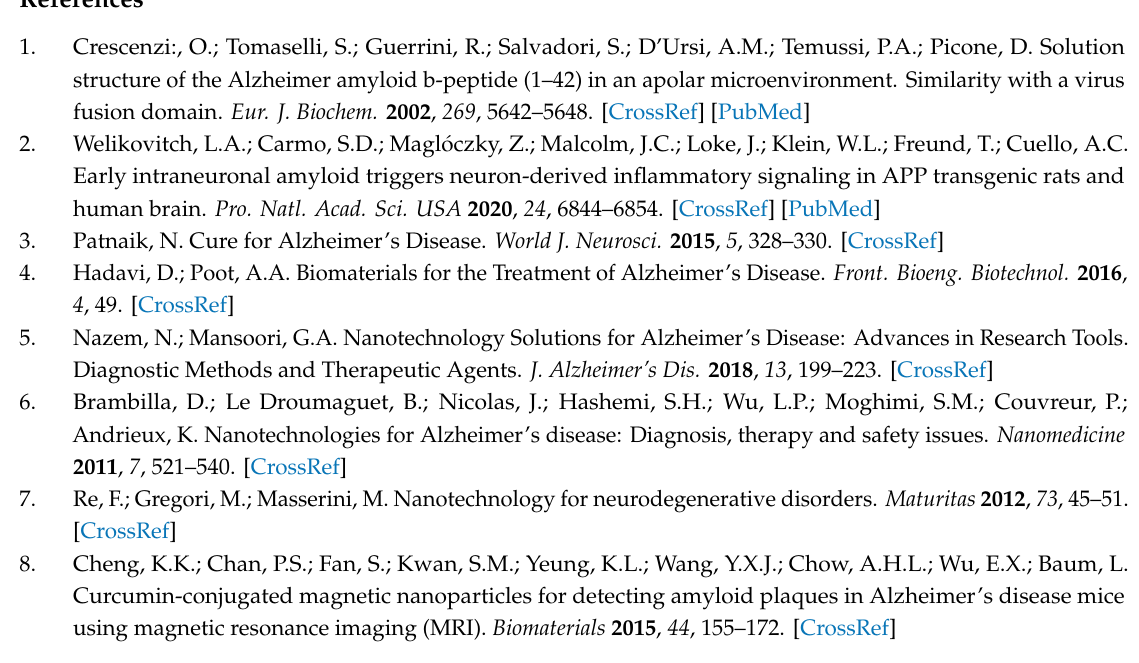
Table S1. The Msr1 , Cd36 , Ager and Cd33 gene expression of BV-2 cells after treatment with NP for 6 h (real-time